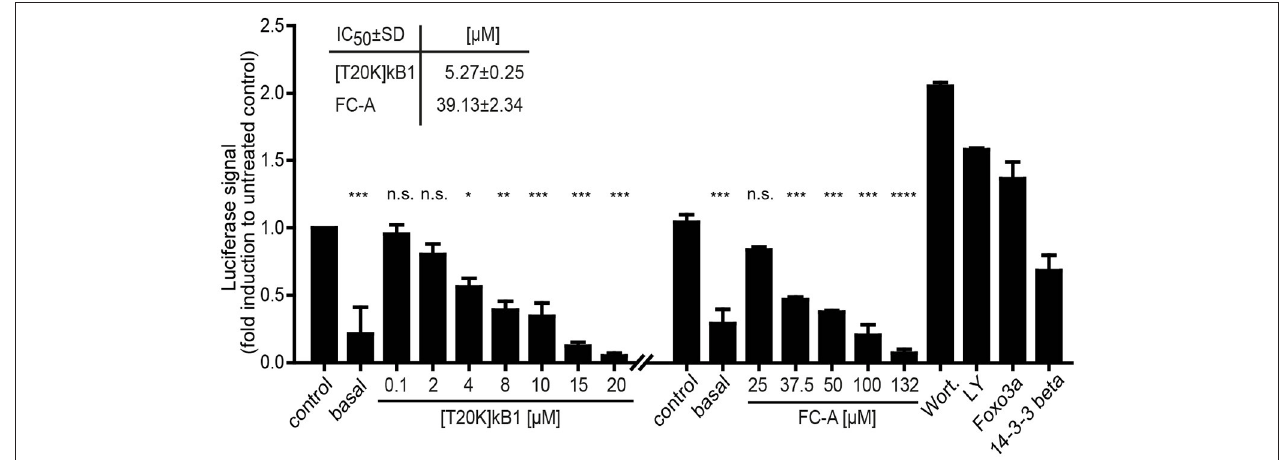
FIGURE 6 | Foxo3a luciferase reporter assay. The modulation of the Akt/PI3K/Foxo3a pathway by the cyclotide [T20K]kB1 binding to 14-3-3 proteins was investigated. HEK293 cells were transiently transfected with Foxo3a-Luc plasmid encoding luciferase under a promotor with Foxo response elements, Foxo3a and 14-3-3 β . For control the reporter plasmid (basal value) was also co-transfected with the single functional effector proteins 14-3-3 β or Foxo3a. Cells were treated under starving conditions with peptide or fusicoccin-A (FC-A) for 4 h or 24 h, respectively. The 14-3-3 stabilizer compound fusicoccin-A is reported to impact the cellular location of 14-3-3 complexed transcription factors (shown by an independent experiment). Wortmannin (Wort.) and LY294002 (LY) served as positive control compounds inhibiting the phosphoinositol 3-kinase and thus interfering with the nuclear export of Foxo3a. IC 50 -values were calculated of two independent experiments using nonlinear regression with curve fitting and constrains to the top and bottom values. Statistics show one-way ANOVA analysis with Bonferroni Post-Hoc test; * P < 0.05, ** P < 0.01, *** P < 0.001; **** P < 0.0001, n.s., not significant.